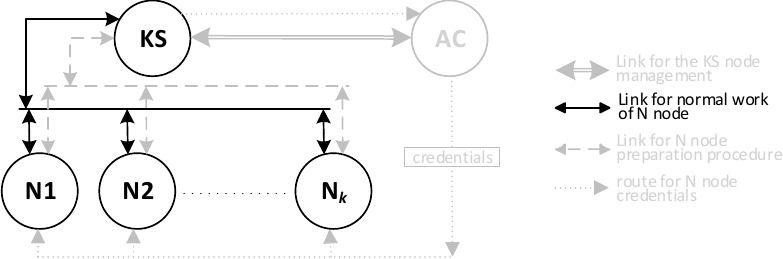
Figure 19. The way the KS node and the N node work together during the procedure for generating session keys.